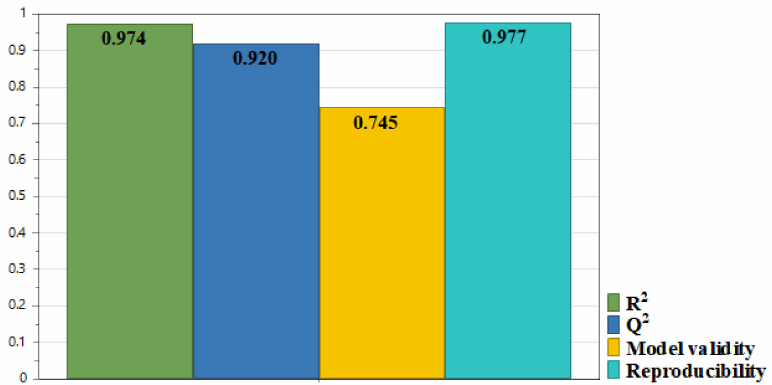
Figure 1. Summary of fit for the model corresponding to response Y, TPC.